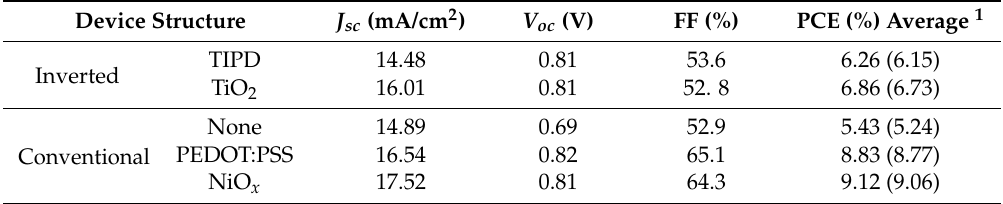
Table 1. Device parameters of OSCs with different structure and different buffer